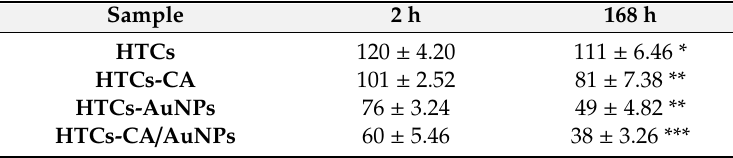
Table 2. Change in the viscosity (mPa · s) of the HTCs, HTCs-capsaicin, HTCs-AuNPs and HTCs-capsaicin / AuNPs upon